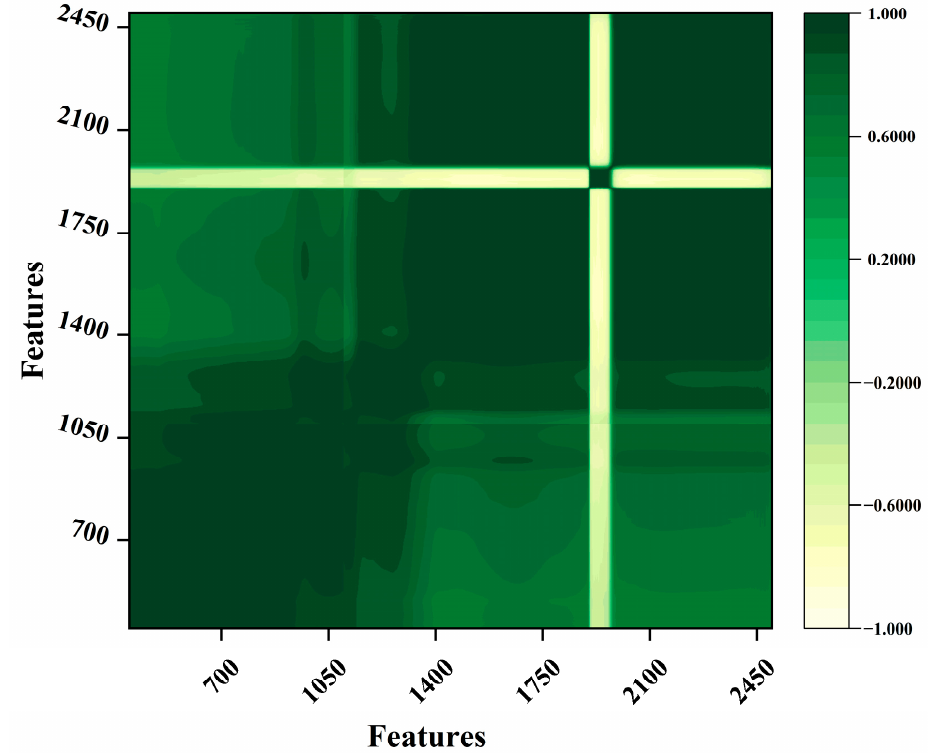
Figure 3. Correlation between 1050 wavelength points.